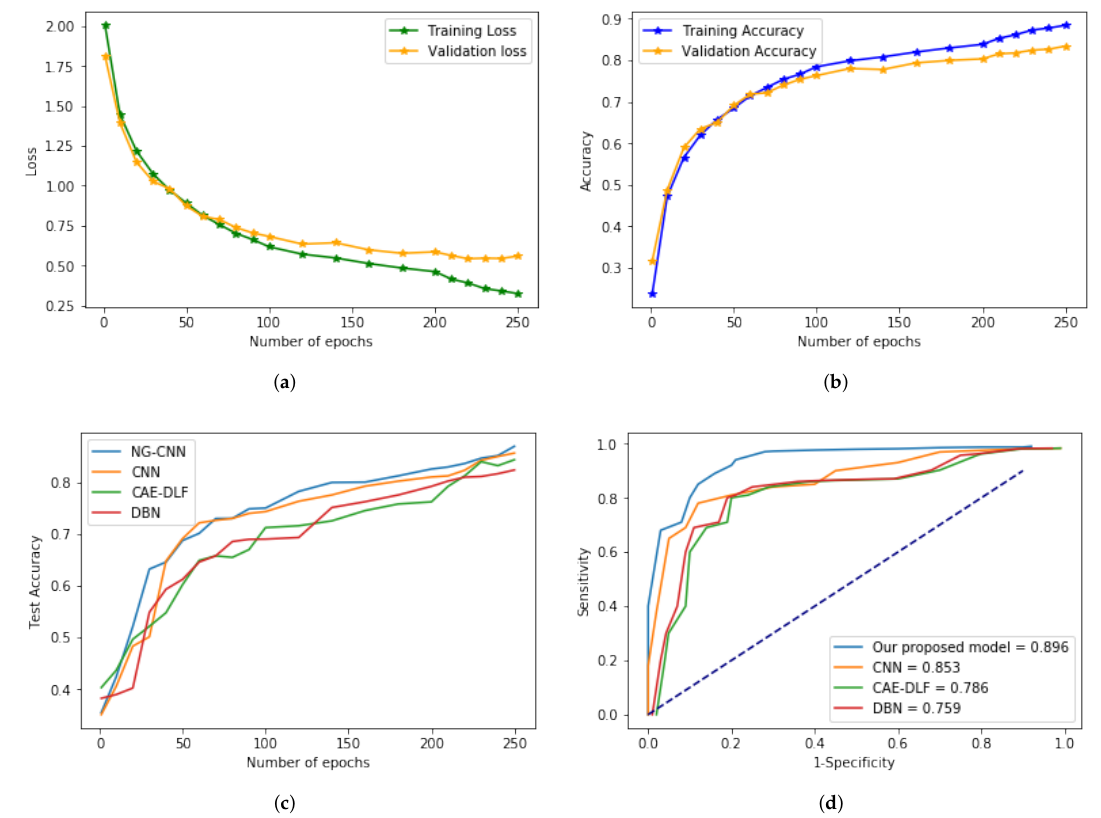
Figure 6. Comparison of the proposed method (NGN-ACDNN) Non-Gaussian Noise aware Autoencoder Convolu- tional Deep neural network with other deep models (CAE-DLF) Convolutional Autoencoder Deep Learning Framework, (CNN) Convolutional neural Network, (DBN) Deep Belief Network: ( a ) describes the Training loss and Validation loss for our proposed CNN model; ( b ) describes the Training accuracy and Validation accuracy for our proposed CNN model; ( c ) describes the Comparison of test accuracy of our proposed model with other deep neural network models; ( d ) describes the ROC curve comparison of our model with